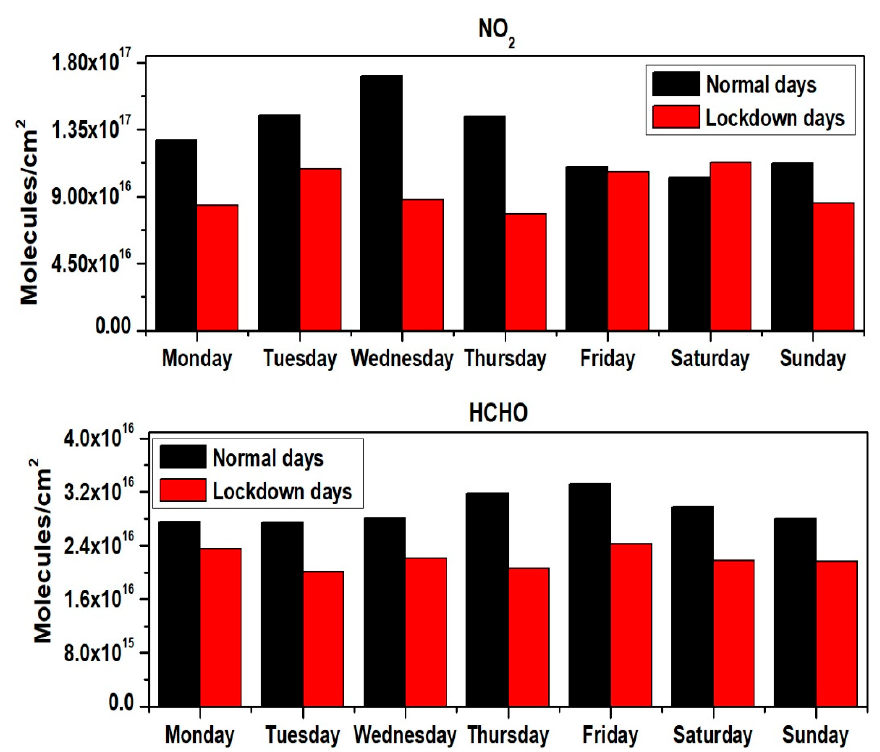
Figure 7. Weekly cycles of nitrogen dioxide (NO 2 ) and formaldehyde (HCHO) vertical column densities (VCDs) observed over Shanghai for normal days as compared to the lockdown period.